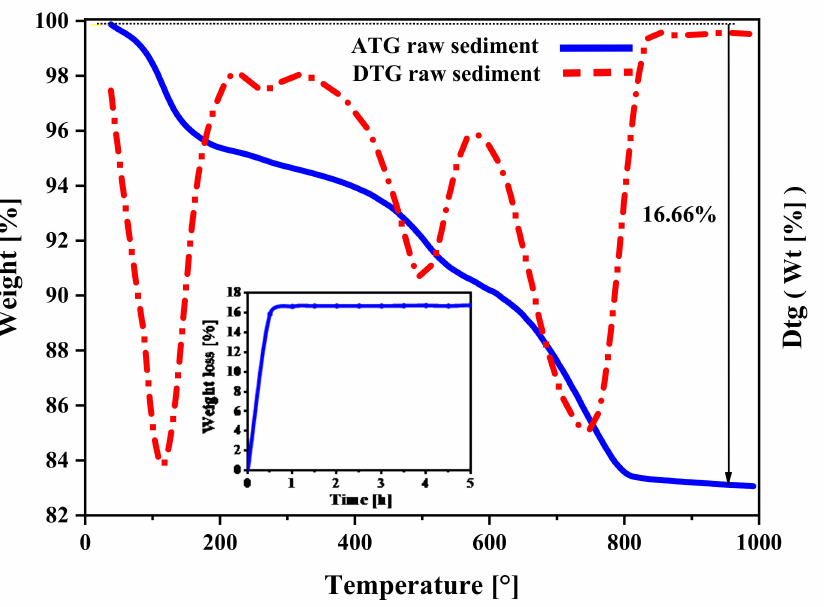
Figure 3. Sediment weight loss variation with time and